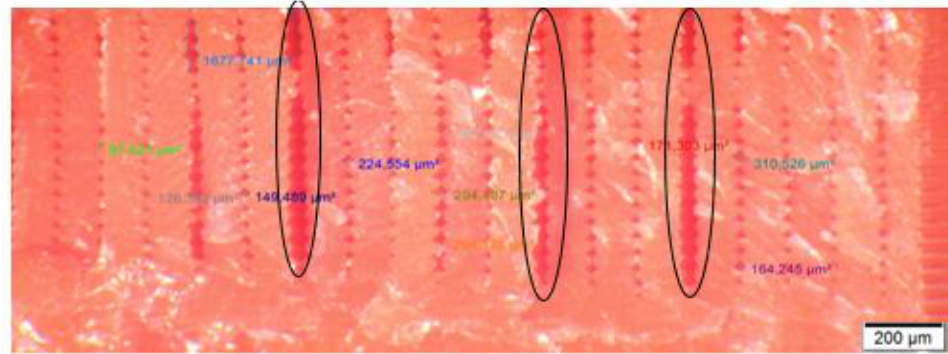
Figure 9. The cross-sectional image of a broken FDM 3D-printed specimen in a 0-bar vacuum condition.